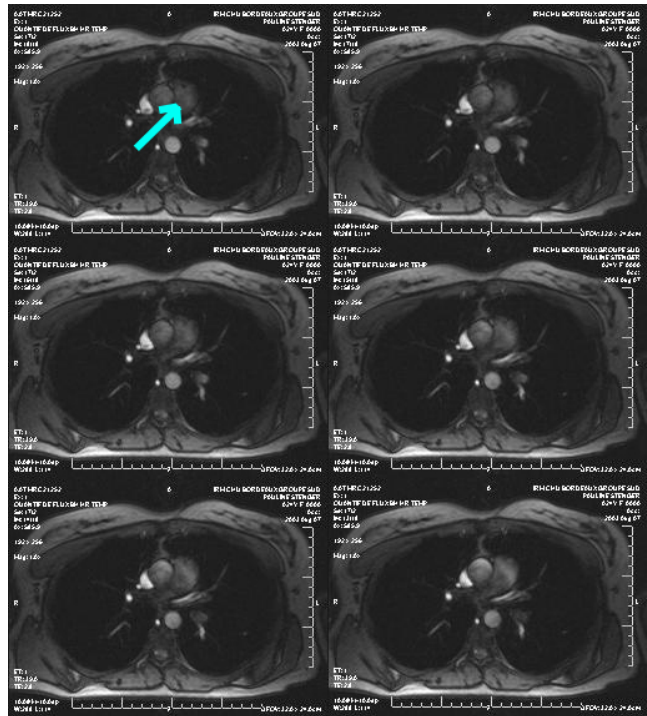
Figure 9. Example of an image sequence (courtesy of CHU Bordeaux, France). The arrow shows the pulmonary artery to